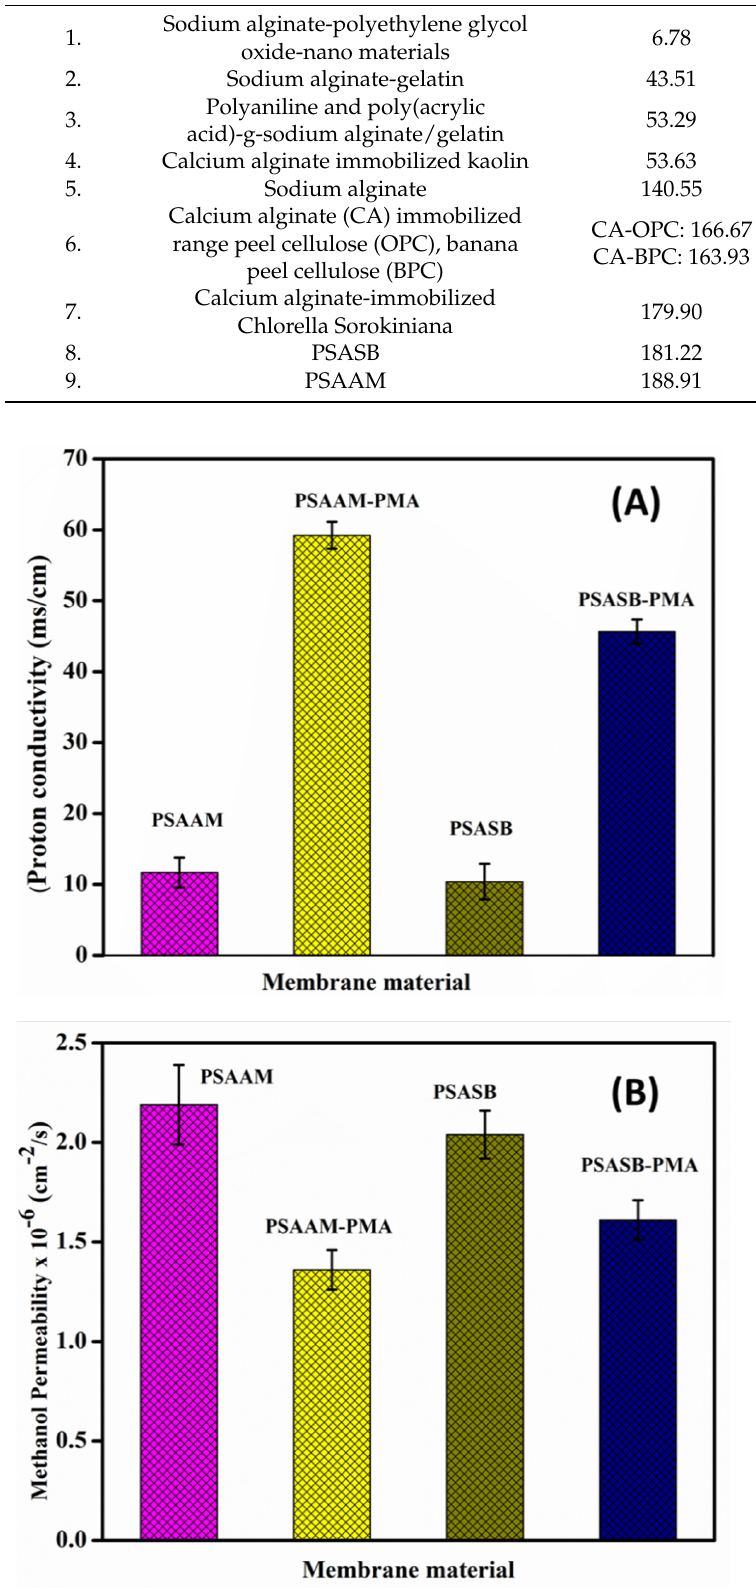
Figure 7. Proton conductivity ( A ) and methanol permeability ( B ) of the PEMs.